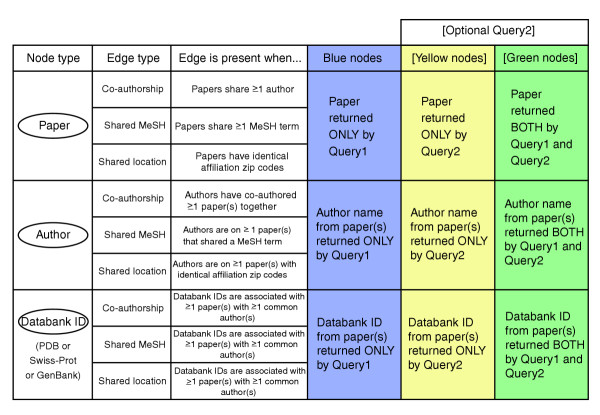
Node and edge reference chart. Nodes and edges can have subtle meanings depending on the parameters used to draw graphs with PubNet. This chart can be used as an aid when interpreting complex graphs. MeSH, Medical Subject Headings; PDB, Protein Data Bank.